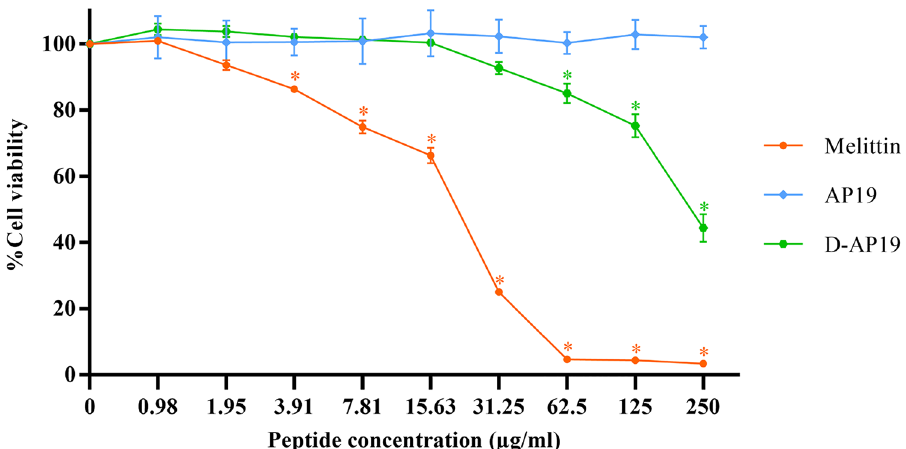
Figure 2. The cytotoxicity of AP19 and D-AP19 against L929 mouse fibroblast cells compared with that of melittin (a positive control). Three independent experiments were performed and the data are presented as mean ± SD. The statistical analyses utilized one-way ANOVA and Tukey’s test at p -value < 0.05 (GraphPad Prism7). Star indicates a significant difference from negative control ( p -value < 0.05).